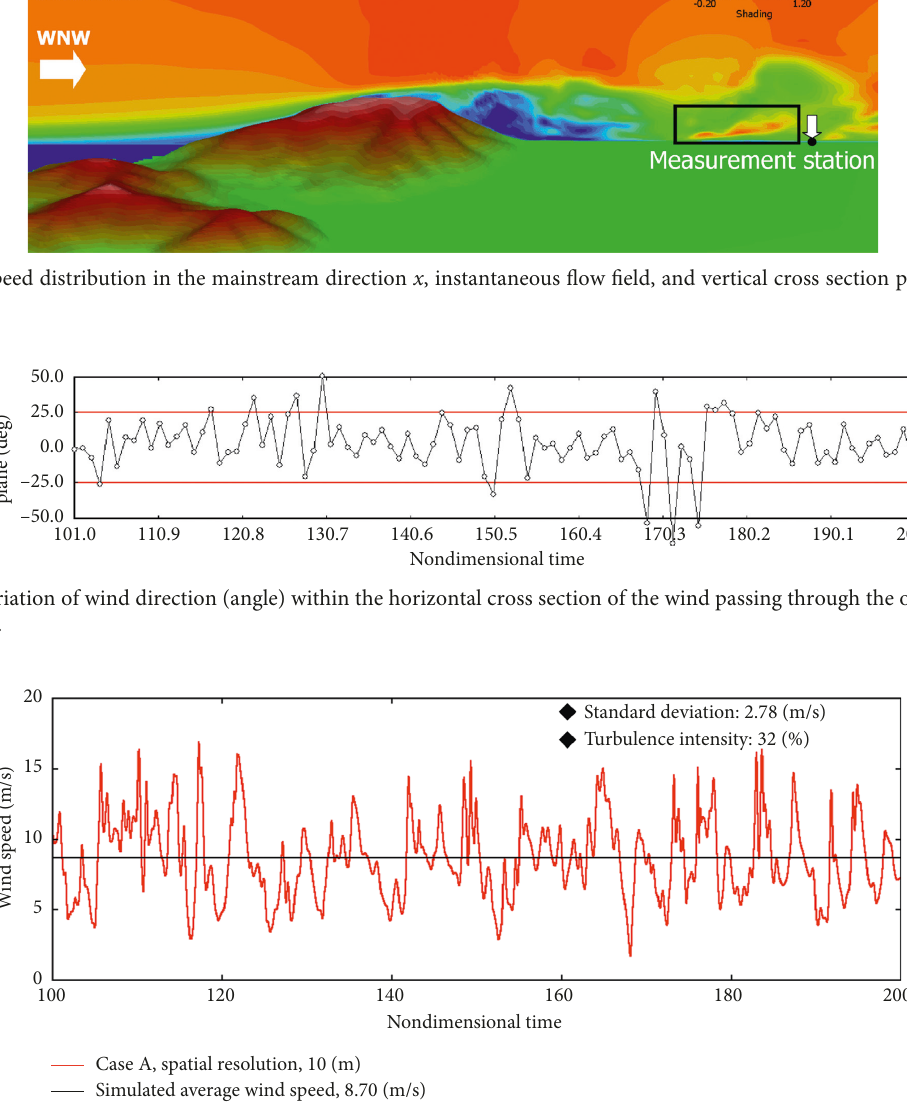
Figure 10: Time variation of wind speed by a computational simulation of wind conditions, with a spatial resolution of 10m at 5m above